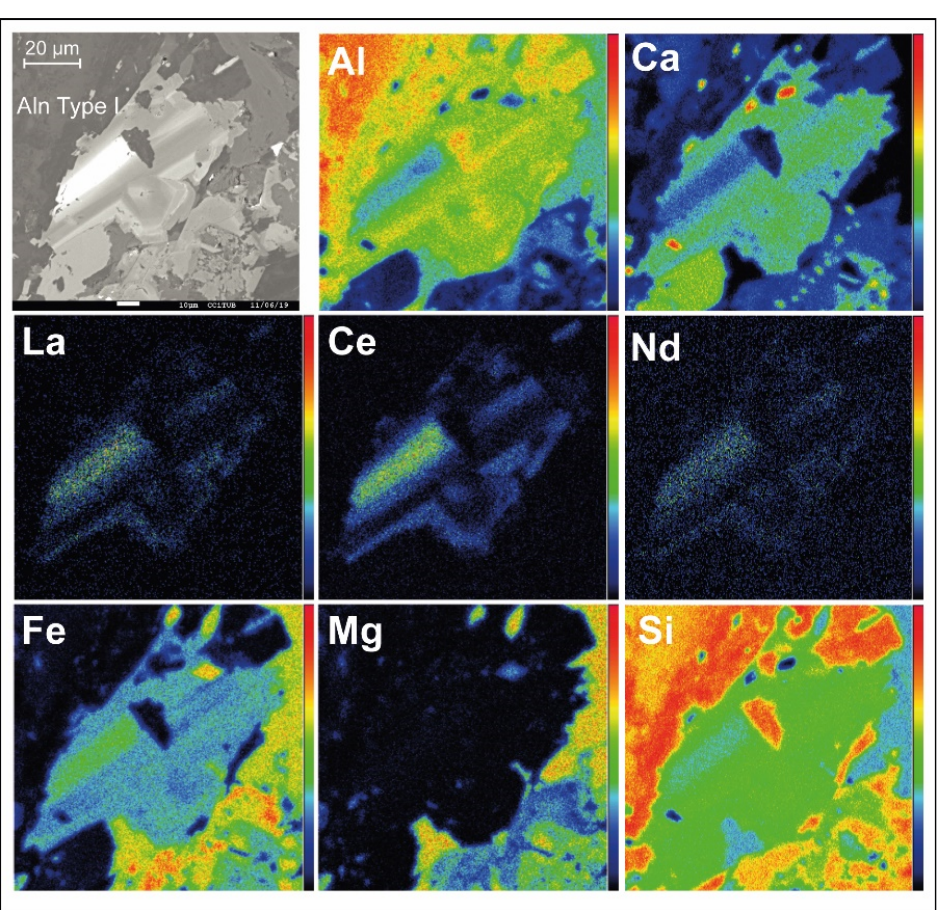
Figure 3. BSE image and concentration maps of a representative allanite Type I composite grain, including Al, Ca, La, Ce, Nd, Fe, Mg and Si. The scales for the color codes on the right-hand side of each image indicate counts of specific X-ray radiation per time unit; that is, red and yellow color indicate higher concentration, and blue-to-black the lower concentration. It is shown that the brightness of the BSE image is proportional to the REE content in allanite, which in this crystal is Ce > La > Nd.